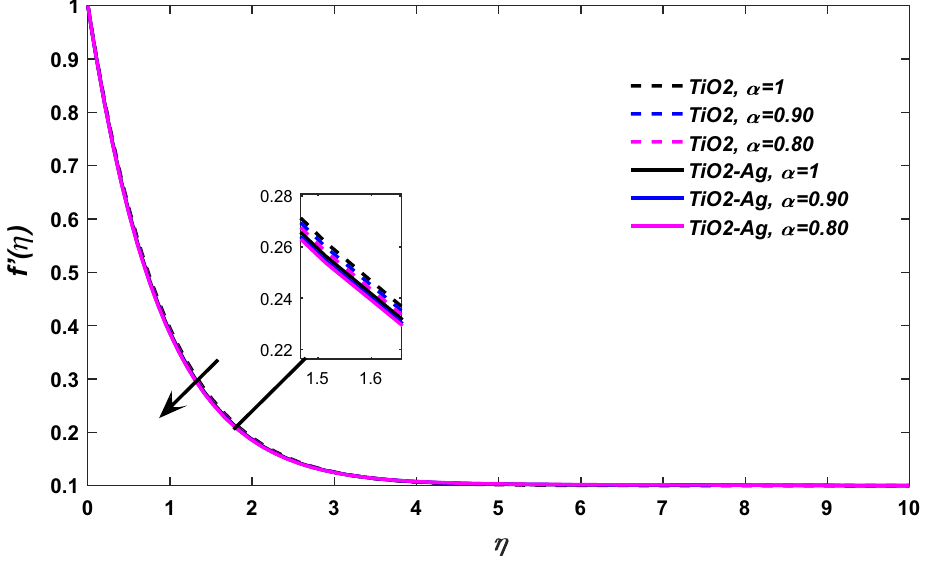
Figure 2. α versus velocity field, When E = (cid:31) = 0.1, φ 1 = φ 2 = 0.02, M = 0.1, Pr = 21.